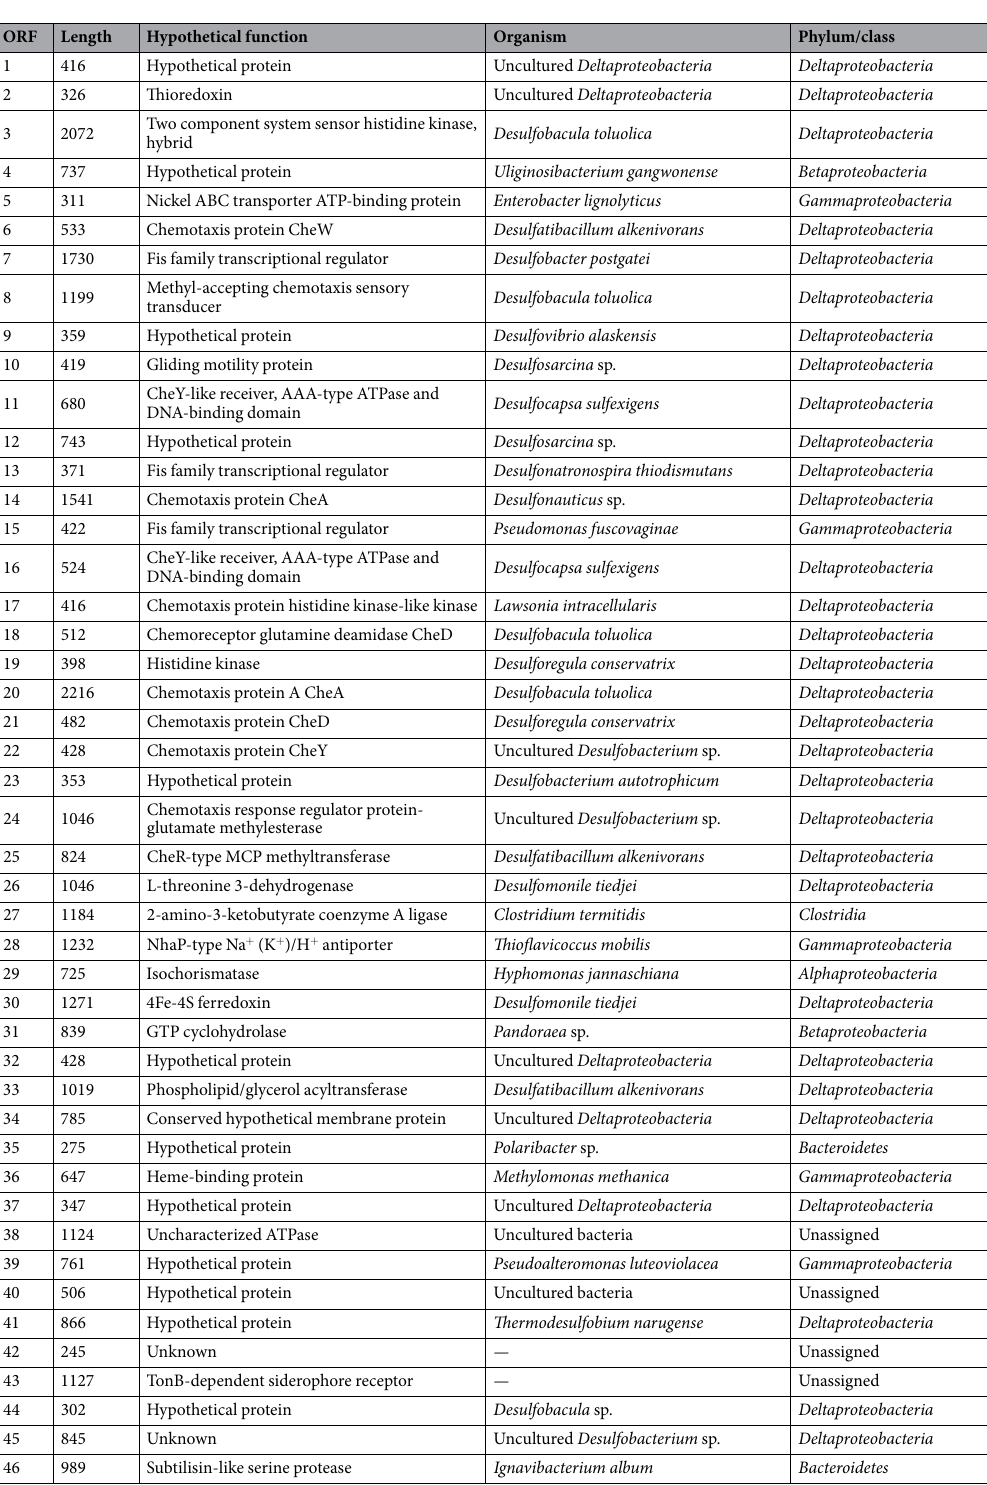
Table 1. Phylogenetic analysis of each ORF in the fosmid f10/17.1H. The table presents the ORF number, the length in bp, the hypothetical function and the phylogenetic affiliation at both genus and phylum/class